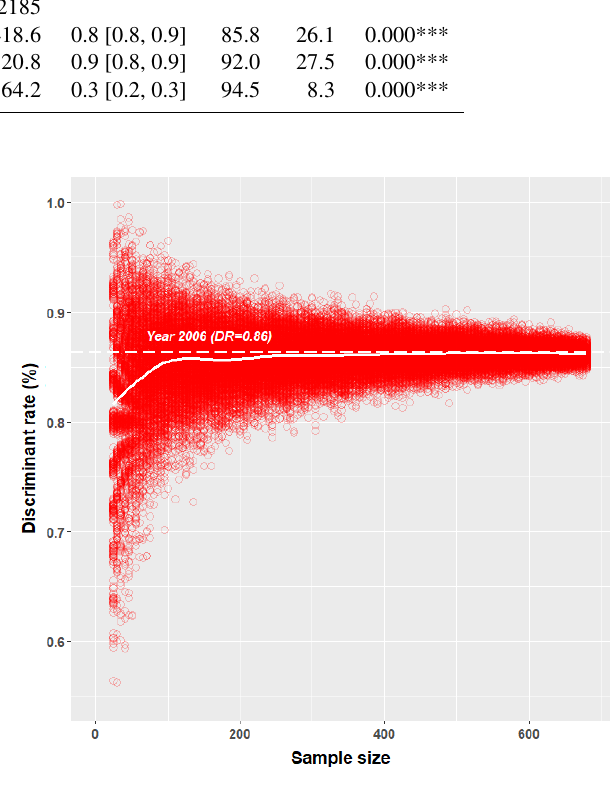
Figure 3. Simulation of the effect of sample size on the esti- mated proportion of correctly classified individuals (discriminant rate) in simulated discriminant function analyses (DFAs) of greater flamingo chicks from Camargue (France). From the largest dataset (year 2006, n = 685 individuals), smaller subsamples were ran- domly selected (ranging from 25 to 685 individuals, with 500 sub- samples per size). For each of these 66000 subsamples, we per- formed a DFA and evaluated the discriminant rate by jackknife cross-validation. Each red empty circle represents one DFA. The thick white line represents the mean discriminant rate computed from the 500 DFAs performed for each sample size. The dashed white line represents the DFA of the year